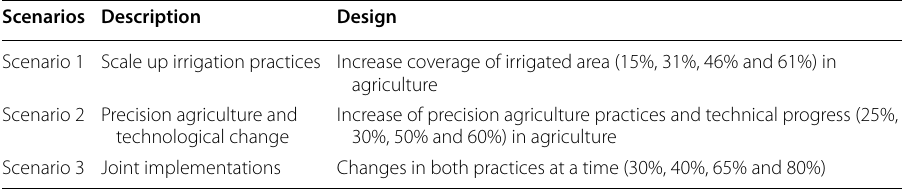
Table 1 Design of policy experiments. Source: author’s own design Scenarios Description Design